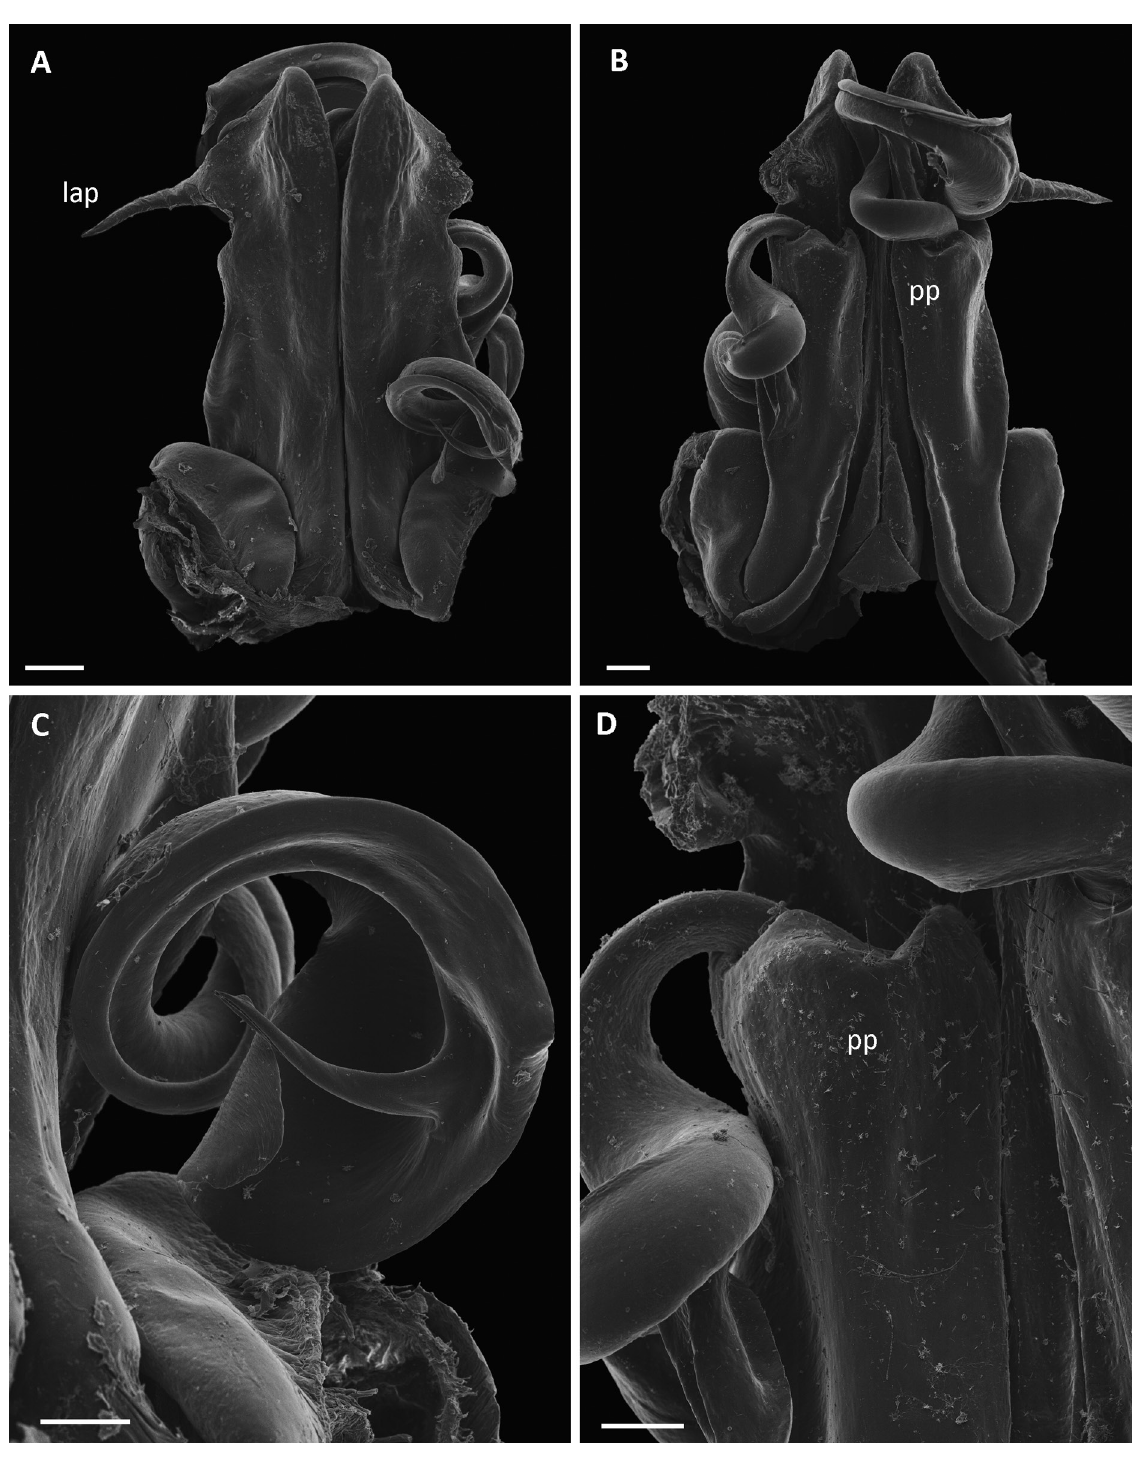
Fig. 5. Odontostreptus maroccanus (Attems, 1914), ♂, from 10 km before Ouzzane (NHMD 53001), gonopods. A . Posterior view. B . Anterior view. C . Tip of left telopodite. D . Detail of left coxa. Abbreviations: lap = lateral metaplical process (broken on left gonopod); pp = proplica. Scale bars: A–B = 0.2 mm; C–D = 0.1